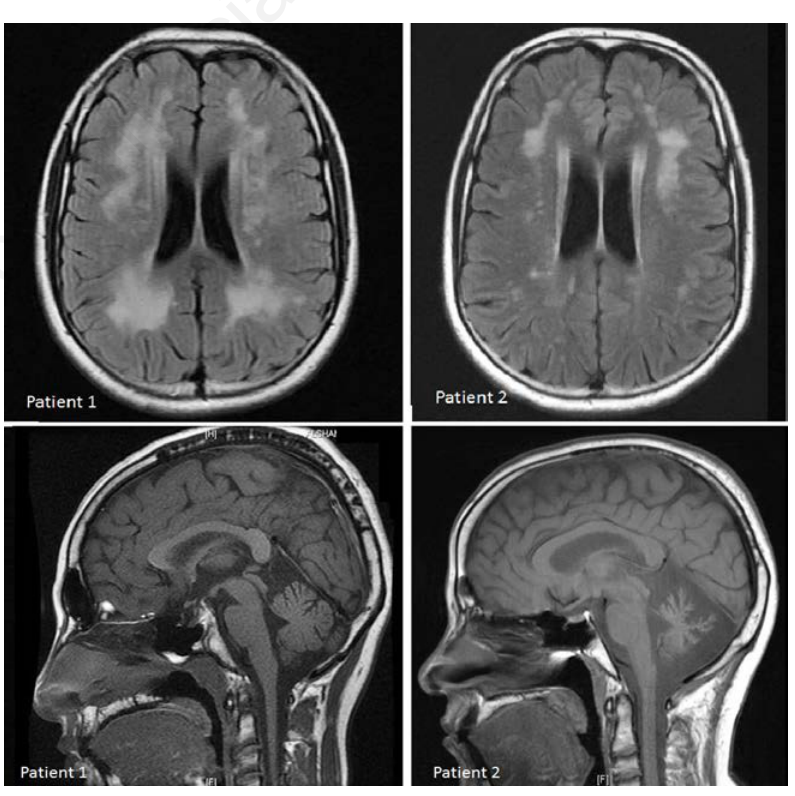
Figure 3. Brain magnetic resonance imaging. Patient 1: mild cerebellar atrophy, mild cor- tical atrophy, significant bilateral confluent white matter abnormalities and partial empty sella with no mass lesions identified. Patient 2: significant cerebellum atrophy, mild cor- tical atrophy, mild white matter changes and normal pituitary